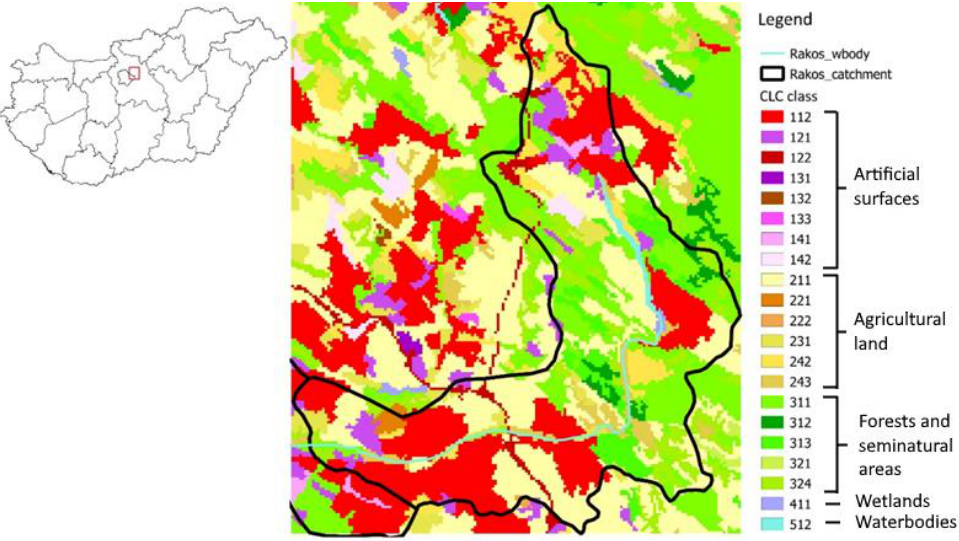
Figure 1. Land cover of the area based on the 2018 CORINE Land Cover dataset [28]. For the Gödöll˝o site, soil data were accessed from two sources. Field capacity (FC), saturation (SAT), and permanent wilting point (PWP) data were downloaded from EU- SoilHydroGrids ver1.0 [30] (https://eusoilhydrogrids.rissac.hu/, accessed on 13 July 2022) with 250 × 250 m spatial resolution, while soil texture data were derived from the DO- SoReMI.hu initiative [22] (with 100 × 100 m spatial resolution). Figure 2 presents the spa- tial variability of the soil texture of the top 30 cm layer within the study area. For the Gödöll˝o site, winter wheat was applied for both observed years (sowing dates: 1 Decem- The climate data (daily precipitation, maximum and minimum temperatures) used in the simulation for the entire catchment were accessed from the Meteorological Database of the Hungarian Meteorological Service (OMSZ) (https://odp.met.hu/, accessed 6 July 2022). Daily potential evapotranspiration was calculated using the Pennman – Monteith equation [31]. Climatic data were available at a 0.1° × 0.1° spatial resolution and were in- terpolated and resampled to the target 100 × 100 m grid. For the other parameters, standard values (which are provided by FAO) were con- sidered. As neither of the modelled crops (wheat and maize) are typically irrigated in the region, irrigation was not applied; only rainfed conditions were considered.